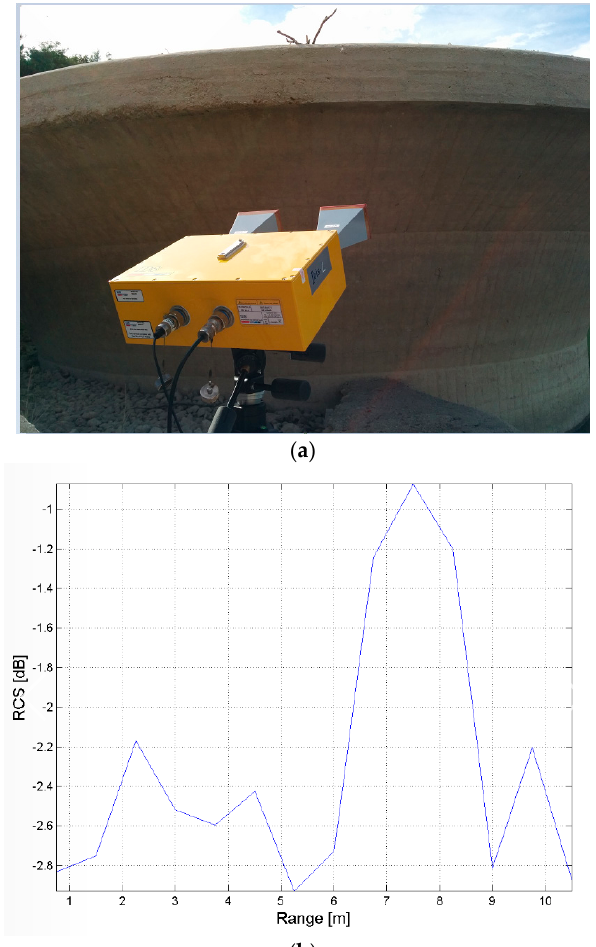
Figure 17. San Pietro dam, Aquilonia. Monitoring of the chalice-shaped spillway. ( a ) observation geometry with detail of the antennas used for the data acquisition; ( b ) Radar cross-section of the radar signal scattered by the structure vs. the range distance from the radar.